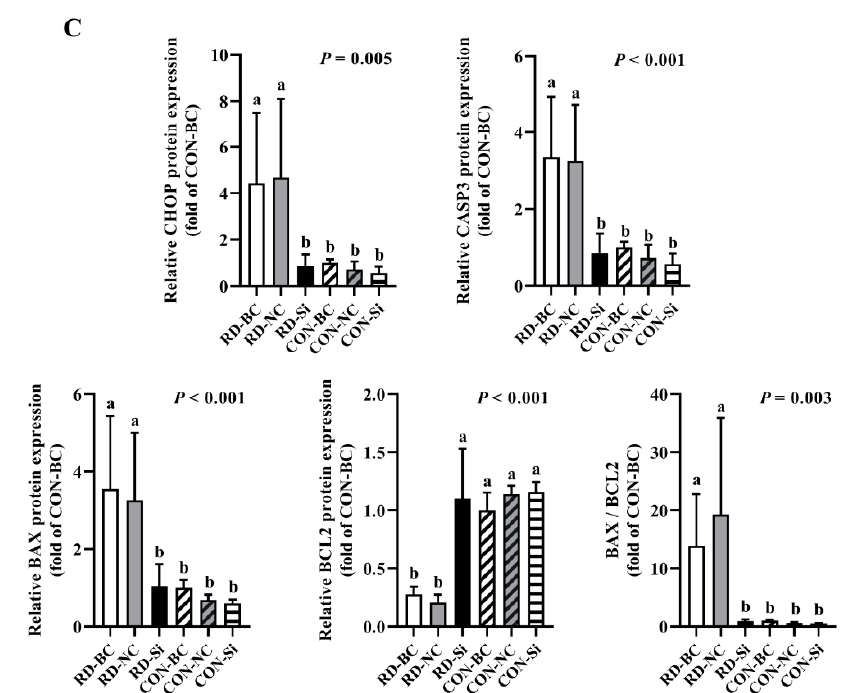
Figure 9. Gene and protein expression analysis of apoptosis-related effects in riboflavin-deficient cells treated with CHOP siRNA . ( A ) Results of CHOP siRNA on the mRNA expression of riboflavin- deficient cells. Representative real-time PCR of CHOP , CASP3 , BAX , BCL2 , and BAX / BCL2 are presented. Each treatment is performed in five replicates ( n = 5). ( B ) Results of CHOP siRNA on protein expression of riboflavin-deficient cells. ( C ) Western blot analysis is performed. Representative Western blot of CHOP, CASP3, BAX, BCL2, and BAX /BCL2 are presented. Different letters indicate significant differences ( p < 0.05). Each treatment is performed in four or six replicates ( n = 4 or